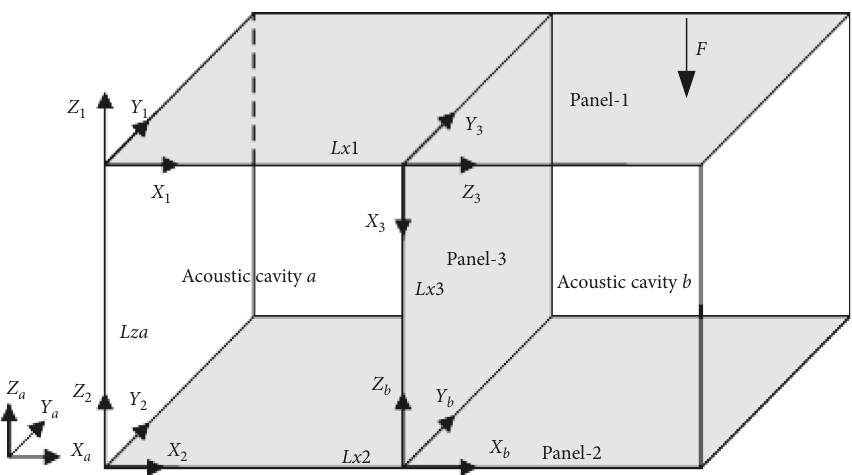
Figure 1: Schematic of the stiffened double panel-cavity coupled system